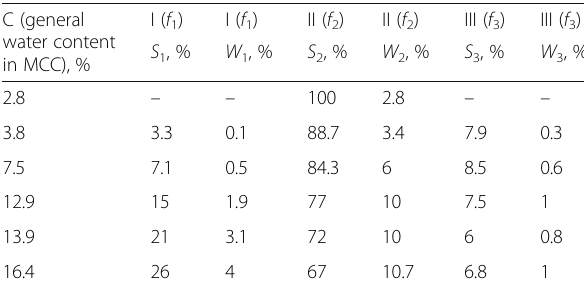
Table 1 Contributions of different types of water and destruction for the MCC samples with different water content in the square of the general peak on the graph dm/dT and its content in the